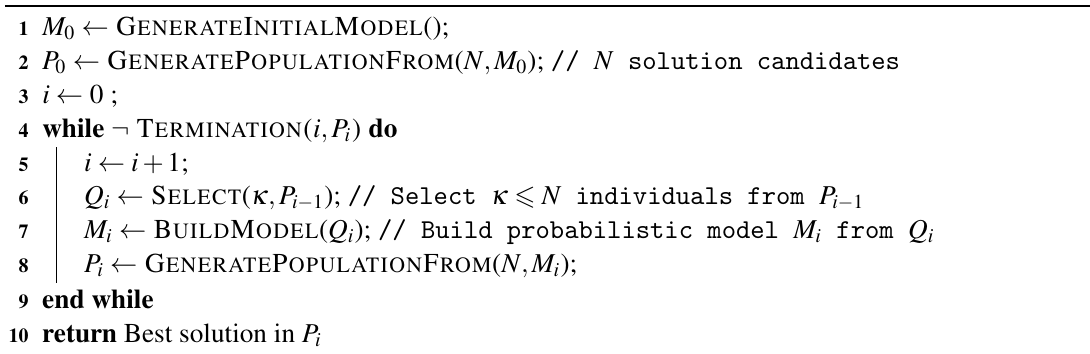
Algorithm 1: Schema of a standard